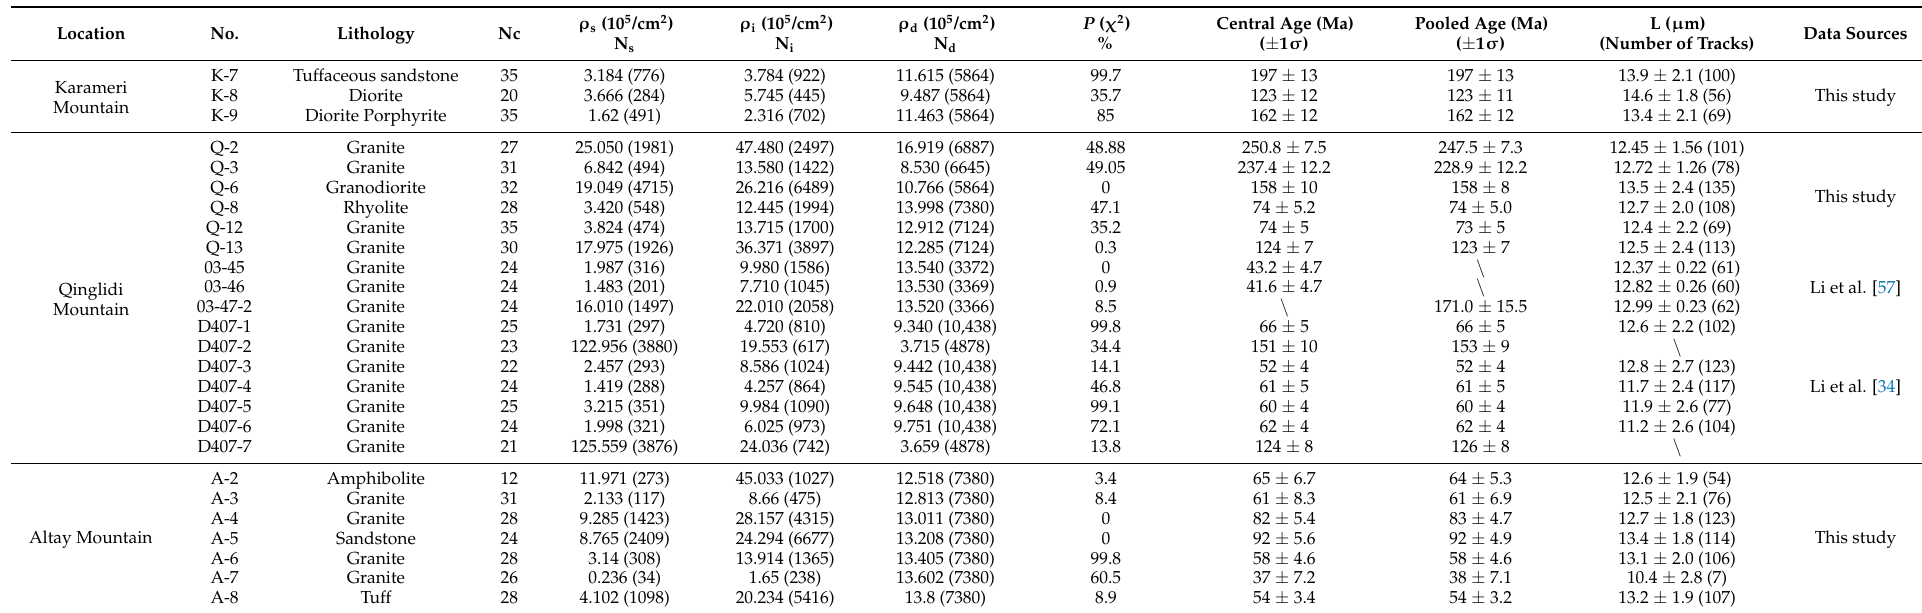
Table 1. AFT ages of samples from the eastern orogenic belts of the Junggar